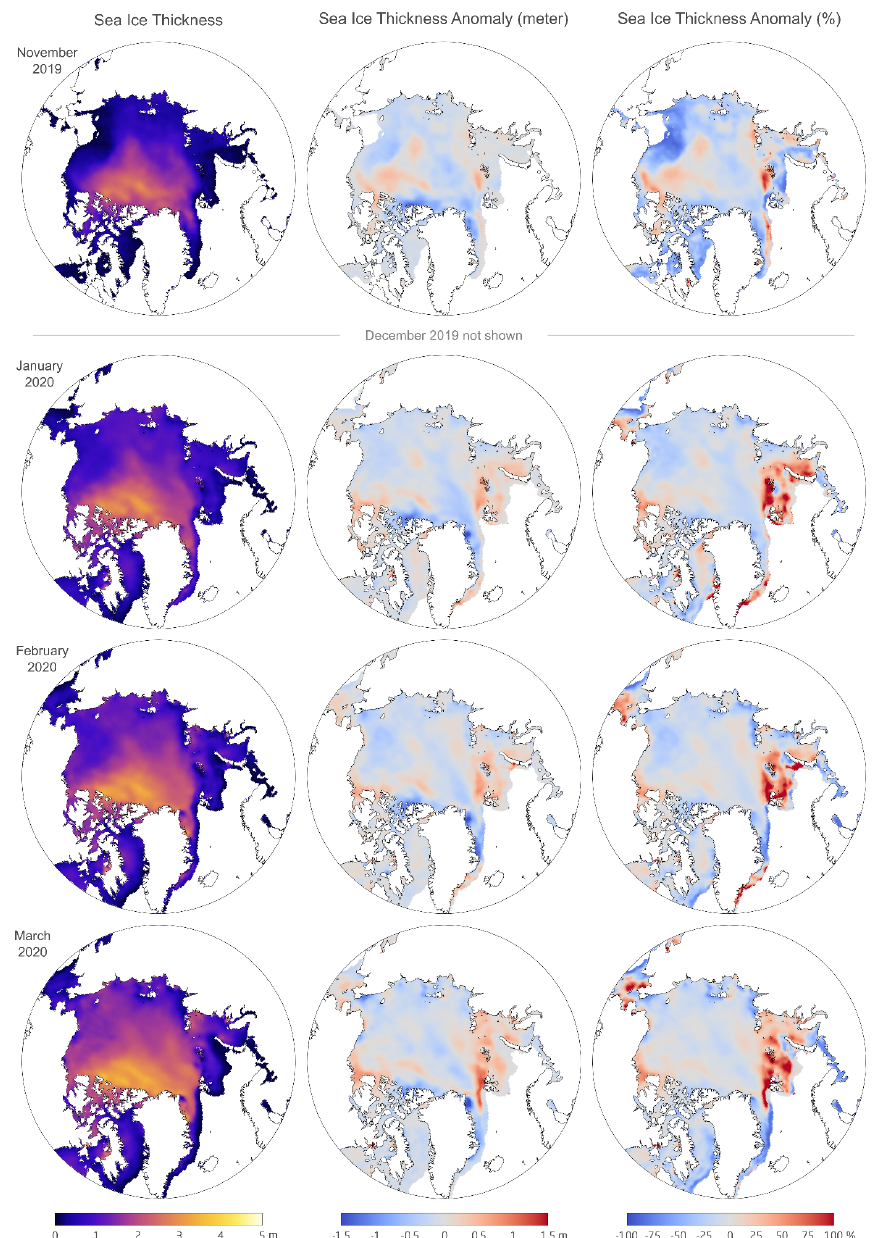
Figure 3. Results based on CryoSat-2/SMOS satellite data analysis for sea ice thicknesses (left column) and anomalies in meters (middle column) and in percent (right column) from November 2019 (top row) through March 2020 (bottom row) (excluding December 2019). Note that values are given relative to the mean condition in the entire data record